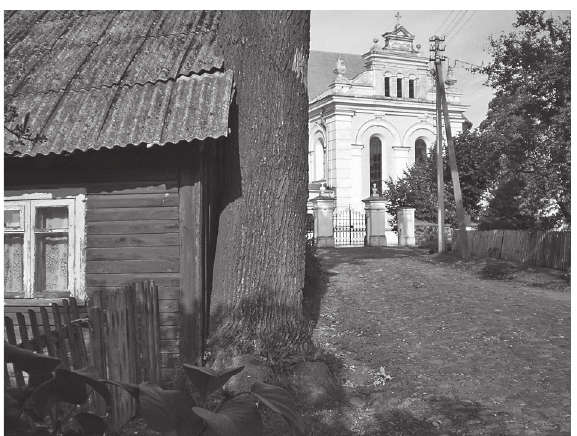
Fig. 1. Bažnyčios street in Šeduva town,